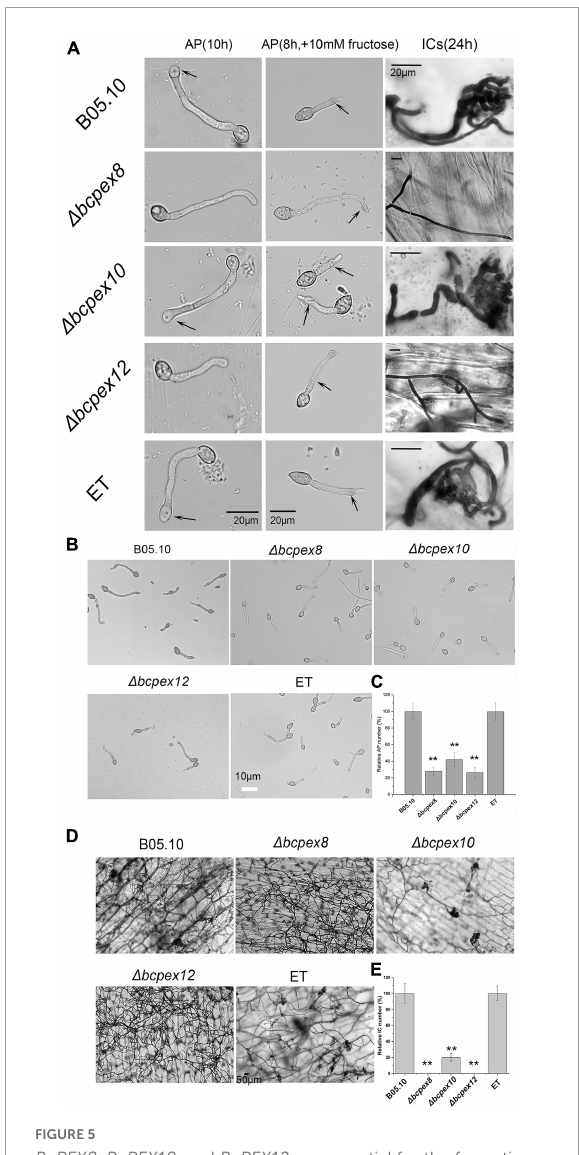
FIGURE5 BcPEX8 , BcPEX10, and BcPEX12 are essential for the formation of IFSs. (A) Loss of BcPEX8 and BcPEX12 in of B. cinerea impairs appressorial or appressorium-like structure formation in the absence (leaf panel) or presence (middle panel) of 10 mM fructose at 10 and 8 hpi, respectively, and abolishes infection cushion formation (right panel) on onion epidermis at 24 hpi. (B) Conidia of the (cid:49) bcpex8, (cid:49) bcpex10 , and (cid:49) bcpex12 mutants and WT and ET strains were performed appressorium formation assay with 10 mM fructose at 8 hpi. (C,E) Quantification of the relative number of formed appressoria at 10 h post-inoculation with 10 mM fructose and infection cushions at 30 hpi (h) by the indicated strains. (D) The indicated strains were performed infection cushion formation assay using conidia suspensions (** p <